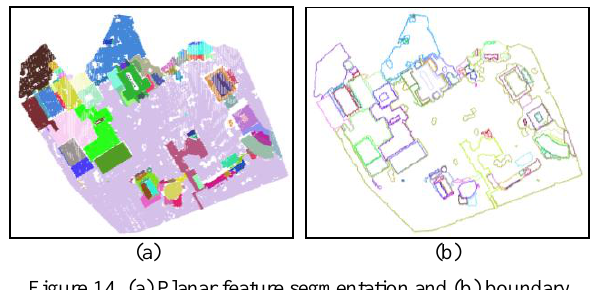
Figure 14. (a) Planar feature segmentation and (b) boundary detection outcome for the utilized laser scanning dataset